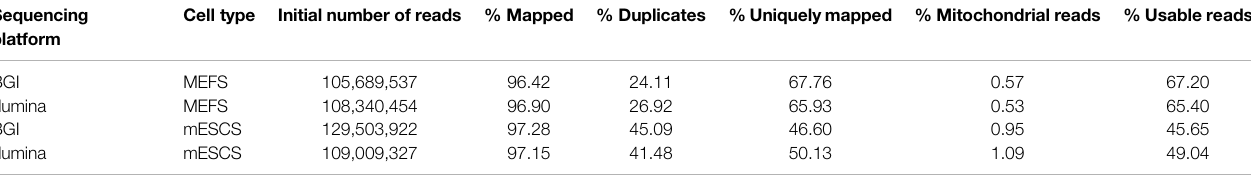
TABLE 1 | Averaged mapping statistics and quality metrics from the analysis of MEF and mESC libraries sequenced on Illumina ’ s HiSeqX10 and BGI ’ s DNBSEQ-G400 instrument. Metrics include a percentage of starting reads that mapped against the mouse reference genome, the percentage of the starting reads with identical sequence considered tobePCRduplicates, thepercentage ofstarting readsthat mapped uniquely against thereferencegenome, thepercentage ofsequencing reads that mapped against the mitochondrial genome, and the percentage of reads that were usable, de fi ned as uniquely mapped against genomic reference genome, deduplicated and not falling in the mitochondrial